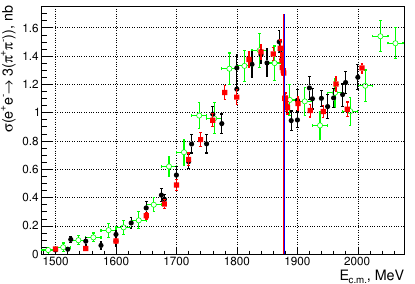
Figure 6. The e + e − → 3( π + π − ) cross section mea- sured with the CMD-3 in 2017 run (red squares), previous measurements are shown by black dots, BaBar results - open green circles. The vertical lines show the p ¯ p and n ¯ n